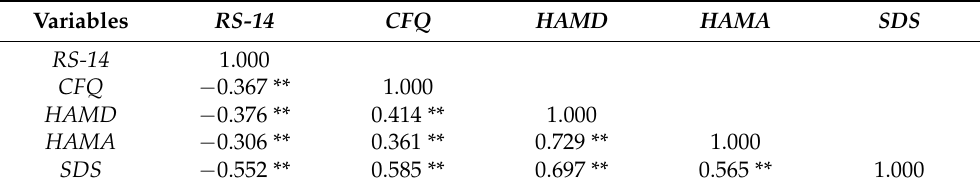
Table 3. Correlation analysis results of depression, anxiety, cognitive fusion, and psychological resilience and its three dimensions.